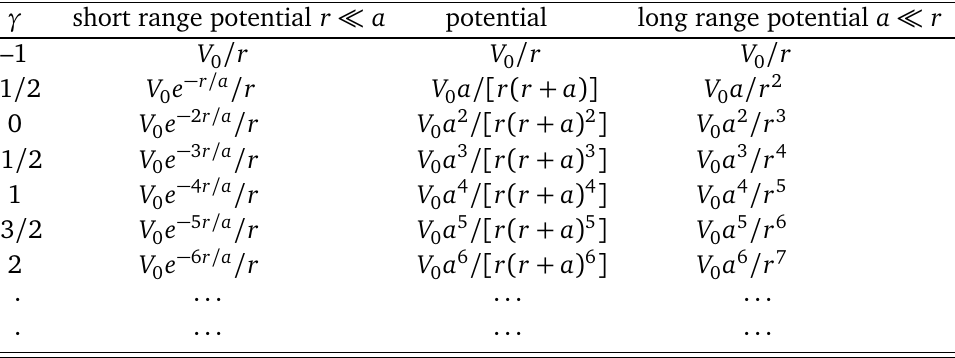
Table 1: The GPT potential V an energy average below the 3BT ( E = 0, ε ε (cid:54) = 0) with two-parameters a and γ . The potential properties for the longer and B shorter ranges are shown with respect to the parameter γ . V which is analytically given by